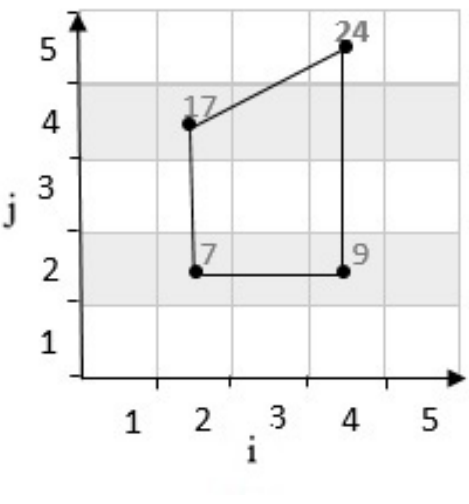
Figure 7. Position of fourth point with negative determinant.